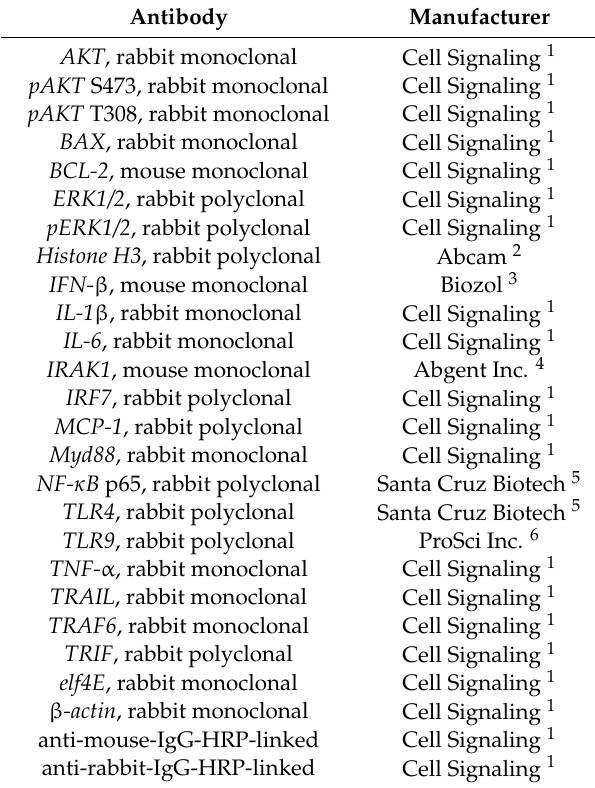
Table 2. Antibodies